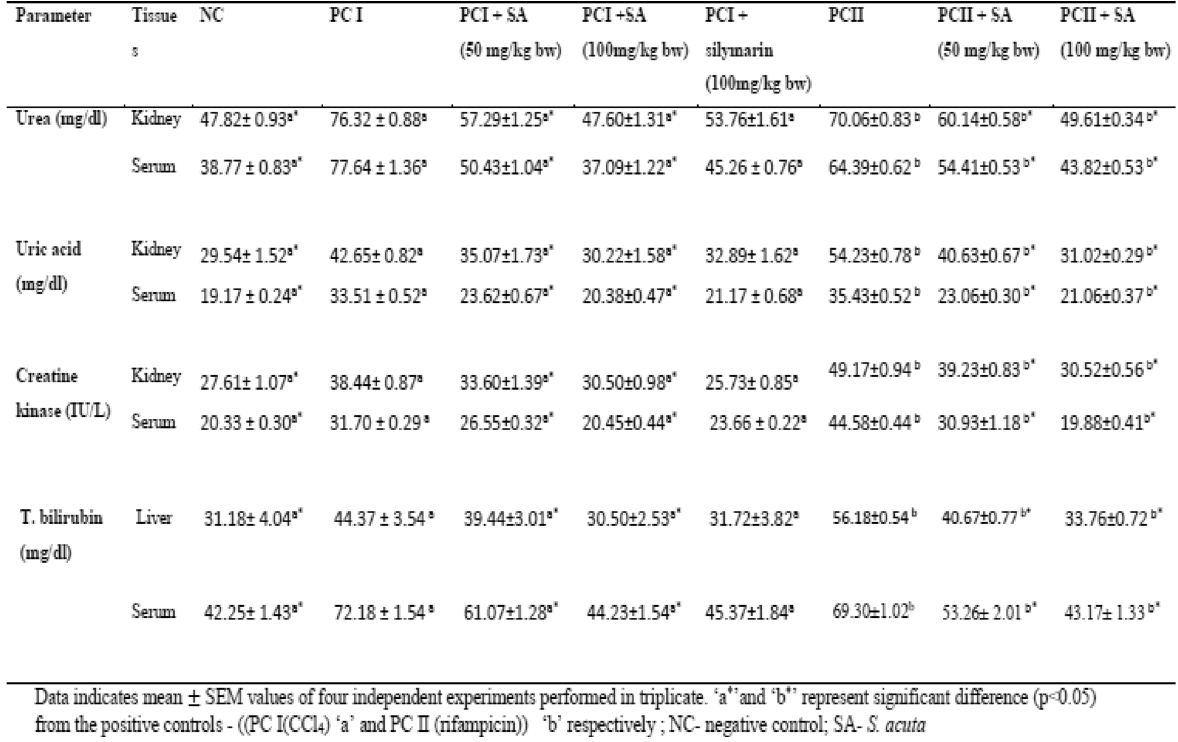
Data indicates mean ± SEM values of four independent experiments performed in triplicate. ‘ a* ’ and ‘ b* ’ represent significant difference ( p <0.05) from the positive controls – ((PC I(CCI4) ‘ a ’ and PC II (rifampicin)) ‘ b ’ respectively; NC- negative control; SA- S.